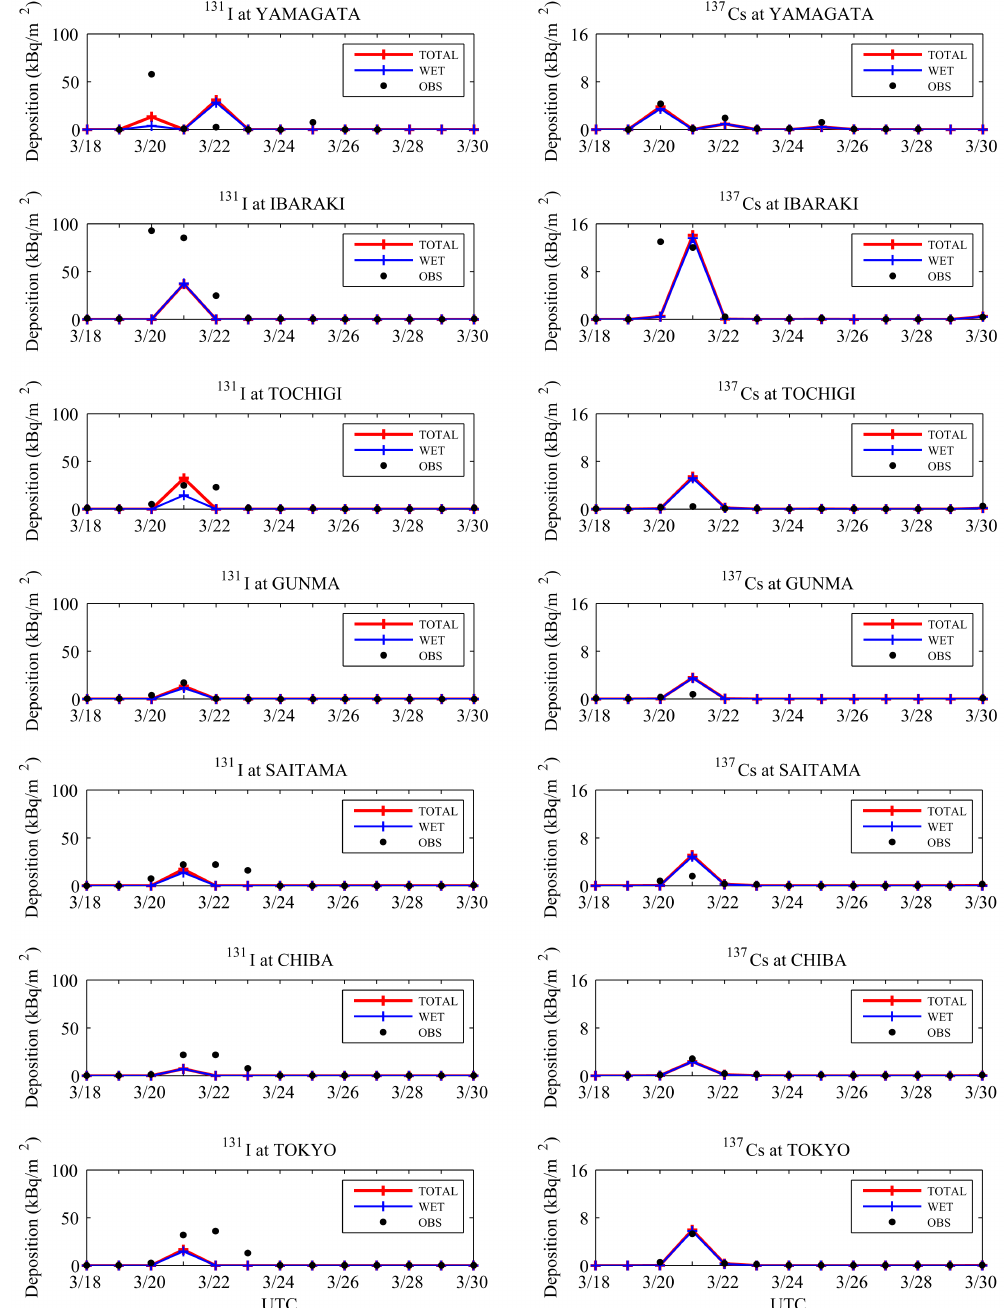
Figure 9. The comparison between simulated (REF case) total daily depositions and the observed data of 131 I and 137